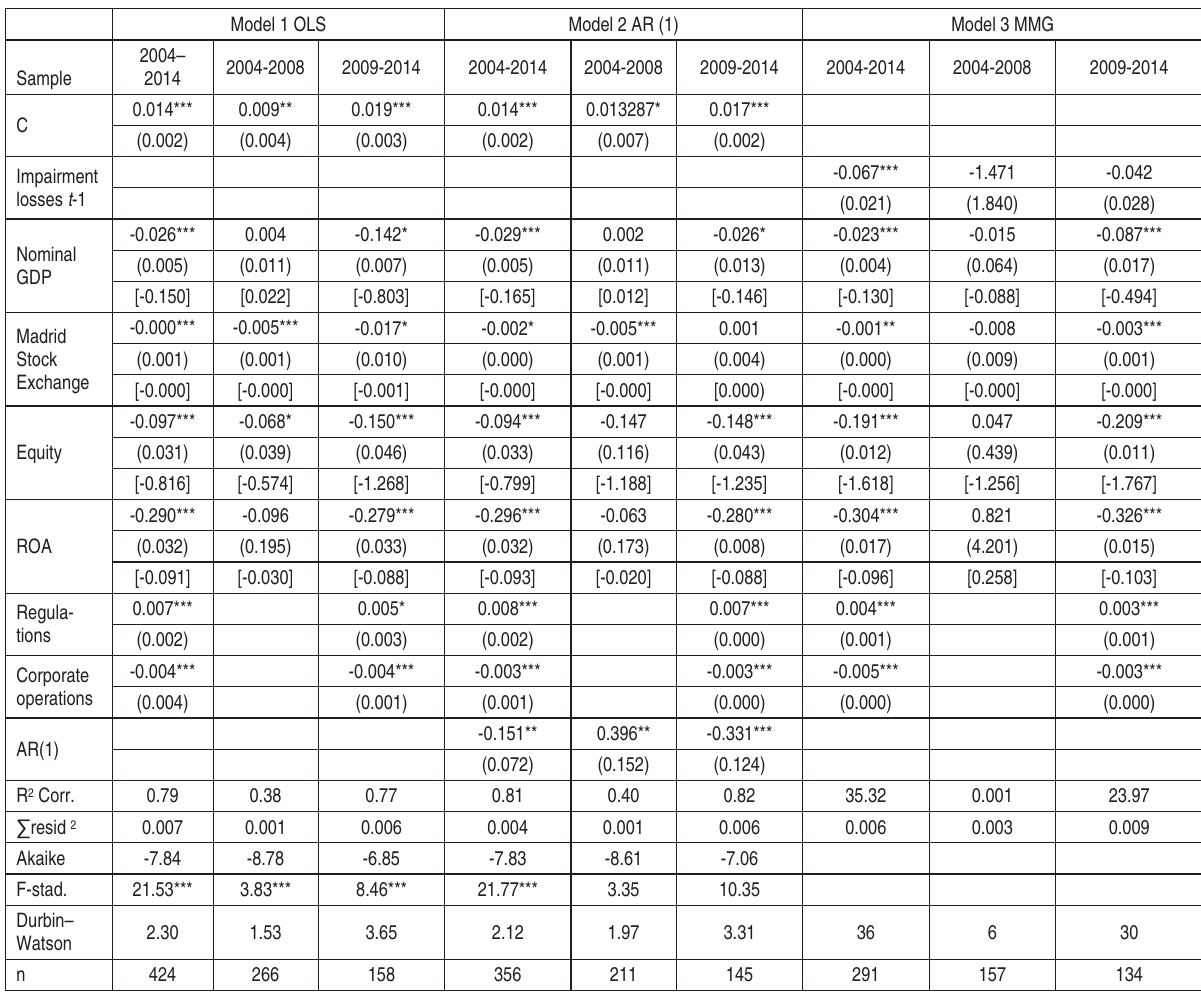
Table 3. Econometric